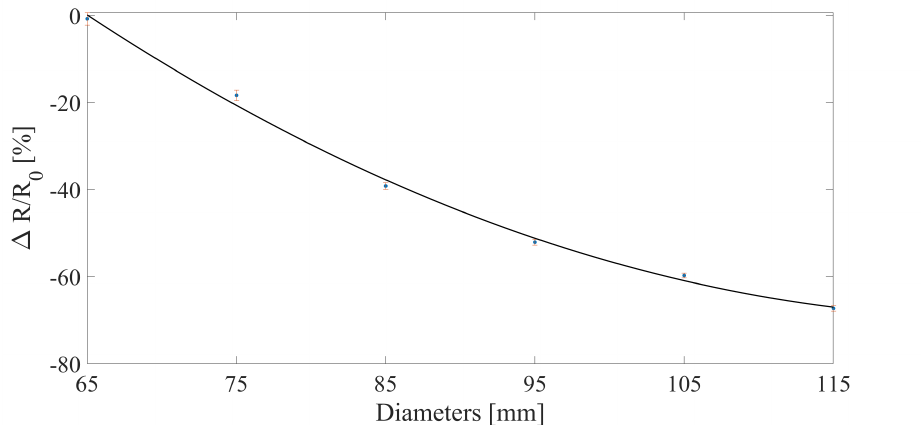
Figure 7. Relative resistance change of the fruit growth sensor when tested on 3D-printed discs ranging from 65 mm to 115 mm. The blue dots represent the mean value of the sensor’s relative resistance change over 30 s at regime, the red errorbars represent the expanded uncertainty, and the black line represents the 2nd order polynomial fitting of the experimental